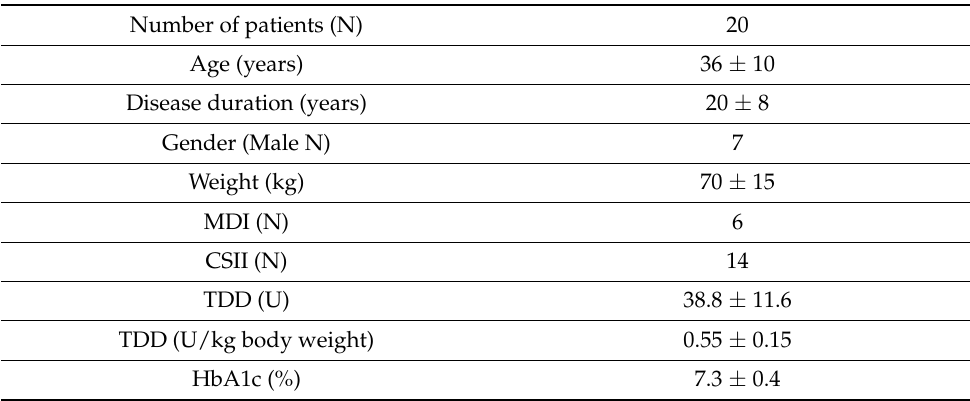
Table 2. Characteristics of patients enrolled in the study.